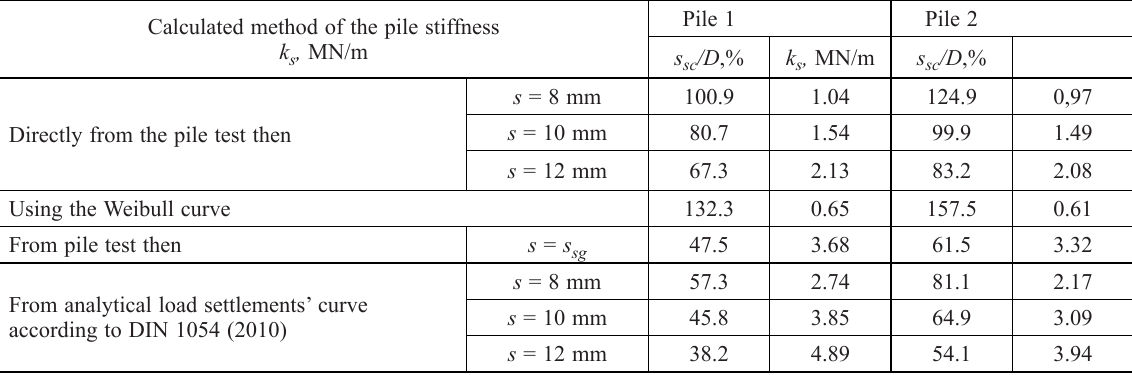
Table 8. Calculated pile stiffness values and relative settlements s sc /D obtained from the pile static test Calculated method of the pile stiffness k